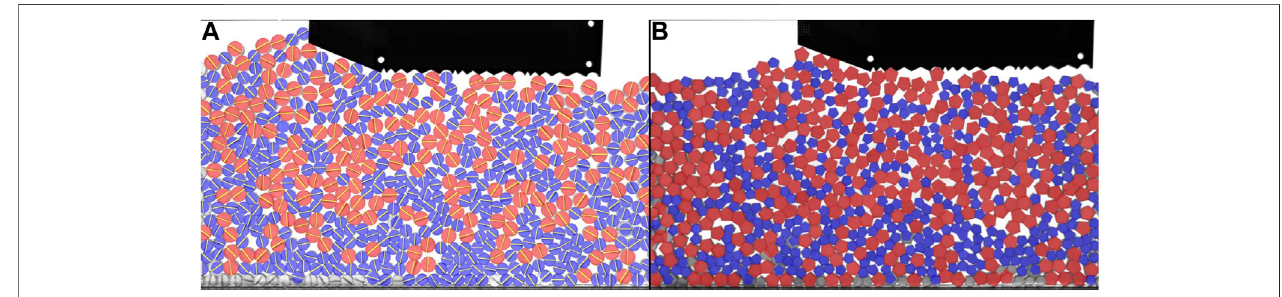
FIGURE 10 | Tracked grains drawn over white light image from experiments for (A) the disk packing and (B) the packing of pentagons. The large grain in the bidisperse packing is drawn as red and the small grain as blue. For disks, orientations are marked with yellow bars.